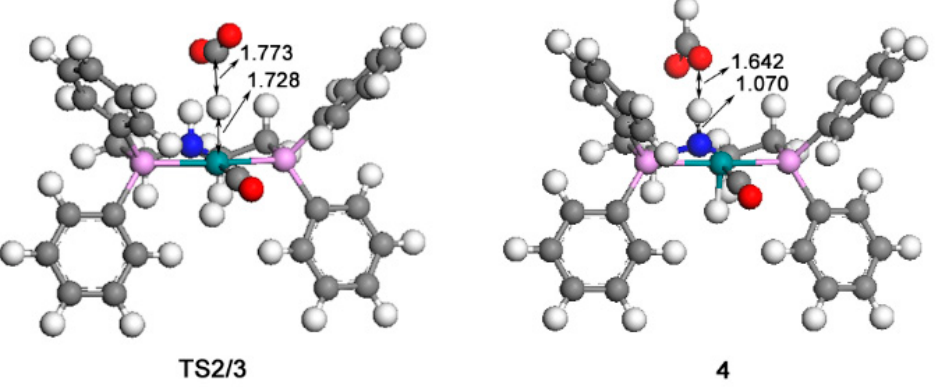
Figure 3. Optimized structures of TS2/3 (359i cm − 1 ) and 4. The unit of bond lengths is expressed in angstrom (Å). (Green balls: Ru; pink: P; red: O; blue: N; grey: C; white: H).